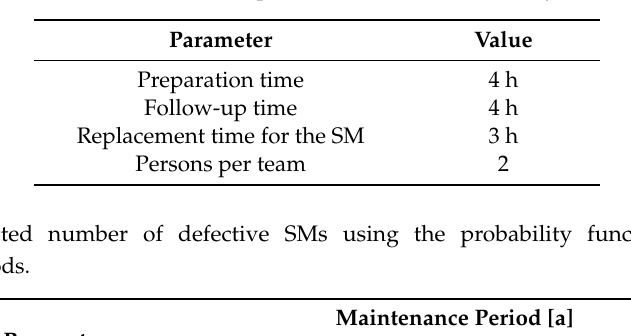
Table 5. Maintenance parameters for the converter yard.